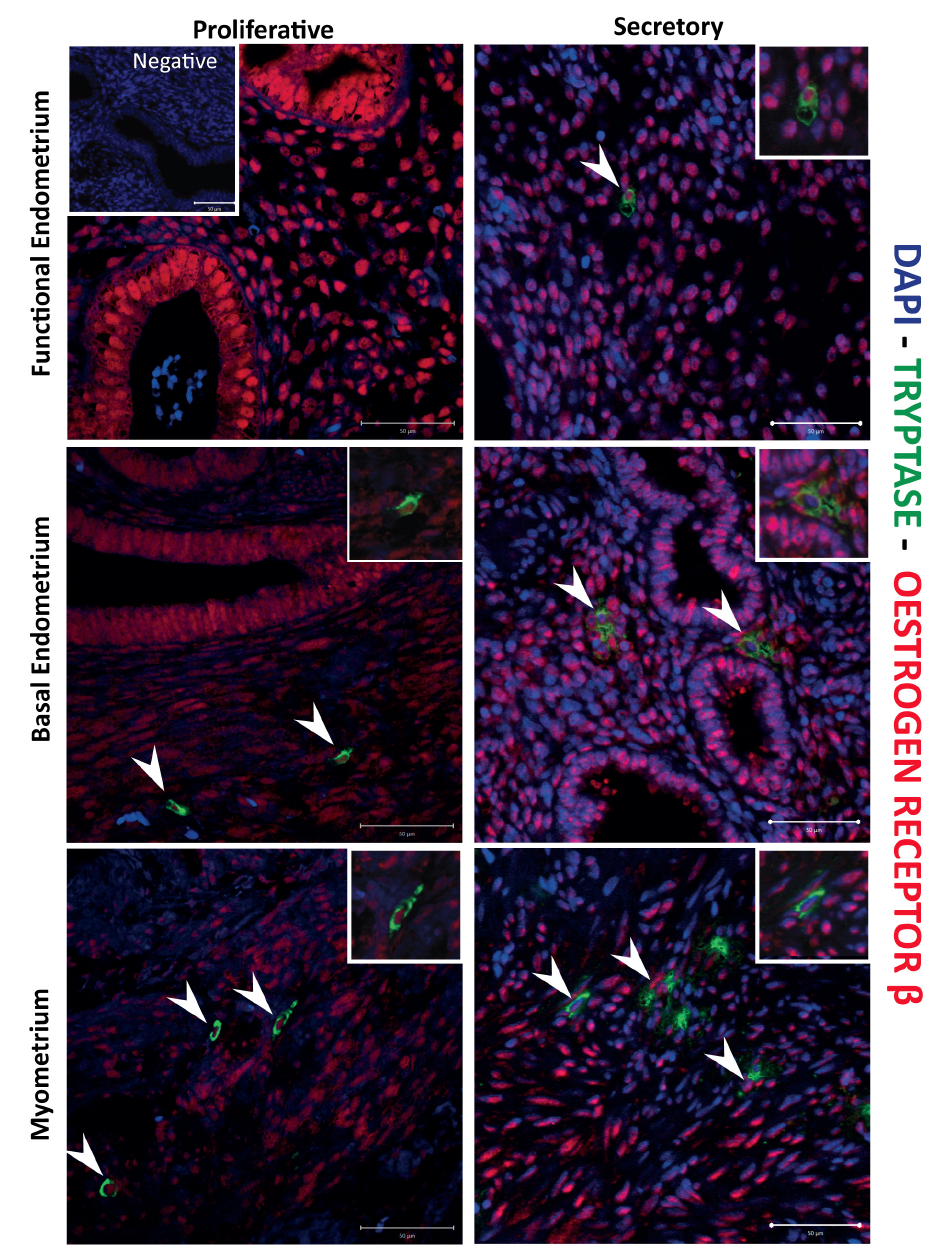
Figure 5. Mast cells are immunopositive for ER β . Immunohistochemistry showed co-localization of ER β in uterine mast cells (MCs). Nuclear expression of ER β receptor (red staining) was detected in MCs across the tissue structures of uterus, myometrium, basal and functional endometrium, and during both the proliferative and secretory phases of the menstrual cycle. (Proliferative n=5, Secretory n=5).